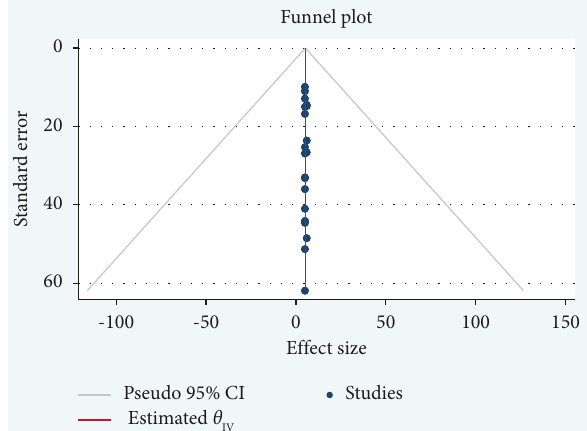
Figure 4: Meta funnel plot presentation, an indication of publi- cation bias among studies in Ethiopia from 2014 to